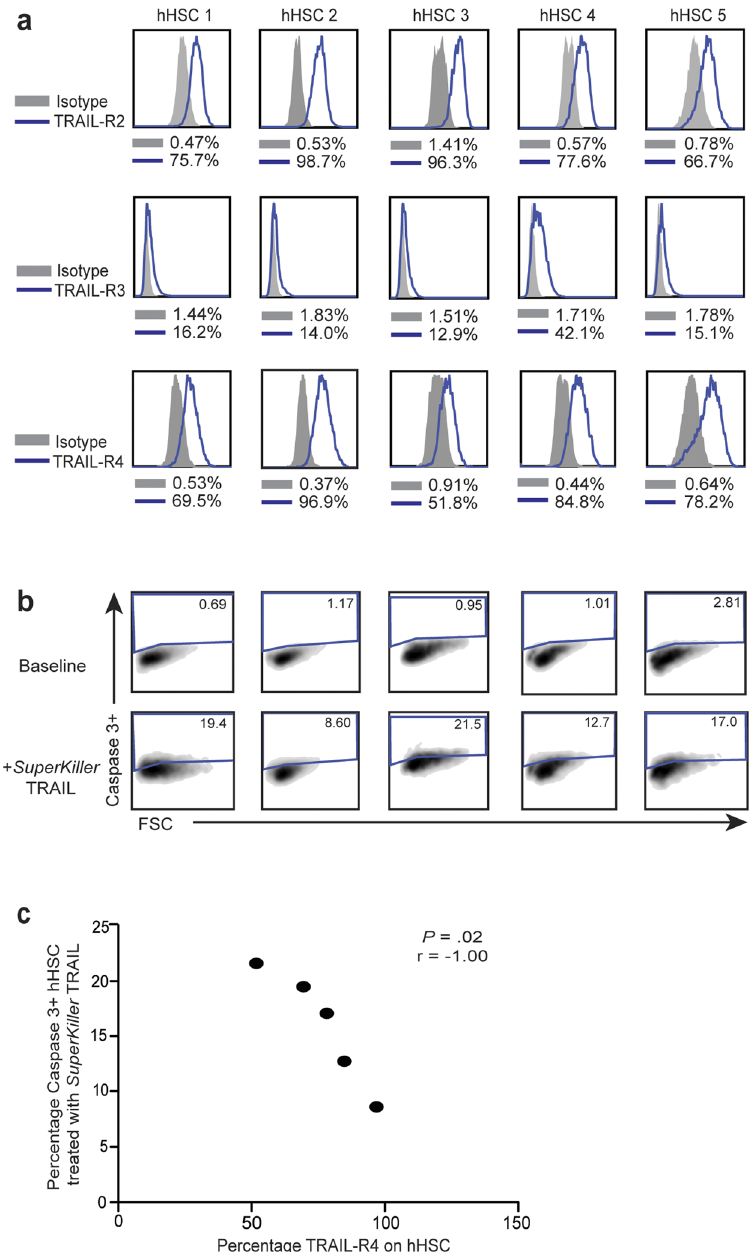
Figure 5. Relationship between expression levels of TRAIL-receptors and resistance to TRAIL-mediated apoptosis. ( a ) Expression levels of TRAIL-R2 (top panel), TRAIL-R3 (middle panel) and TRAIL-R4 (bottom panel) in blue against matched isotype (grey) on in vitro culture-activated hHSC from five different donors (hHSC1–5). ( b ) Levels of induction of caspase-3 in hHSC at baseline and on in vitro treatment with SuperKiller TRAIL. ( c ) Correlation of expression levels TRAIL-R4 on hHSC against their capacity to undergo TRAIL- mediated